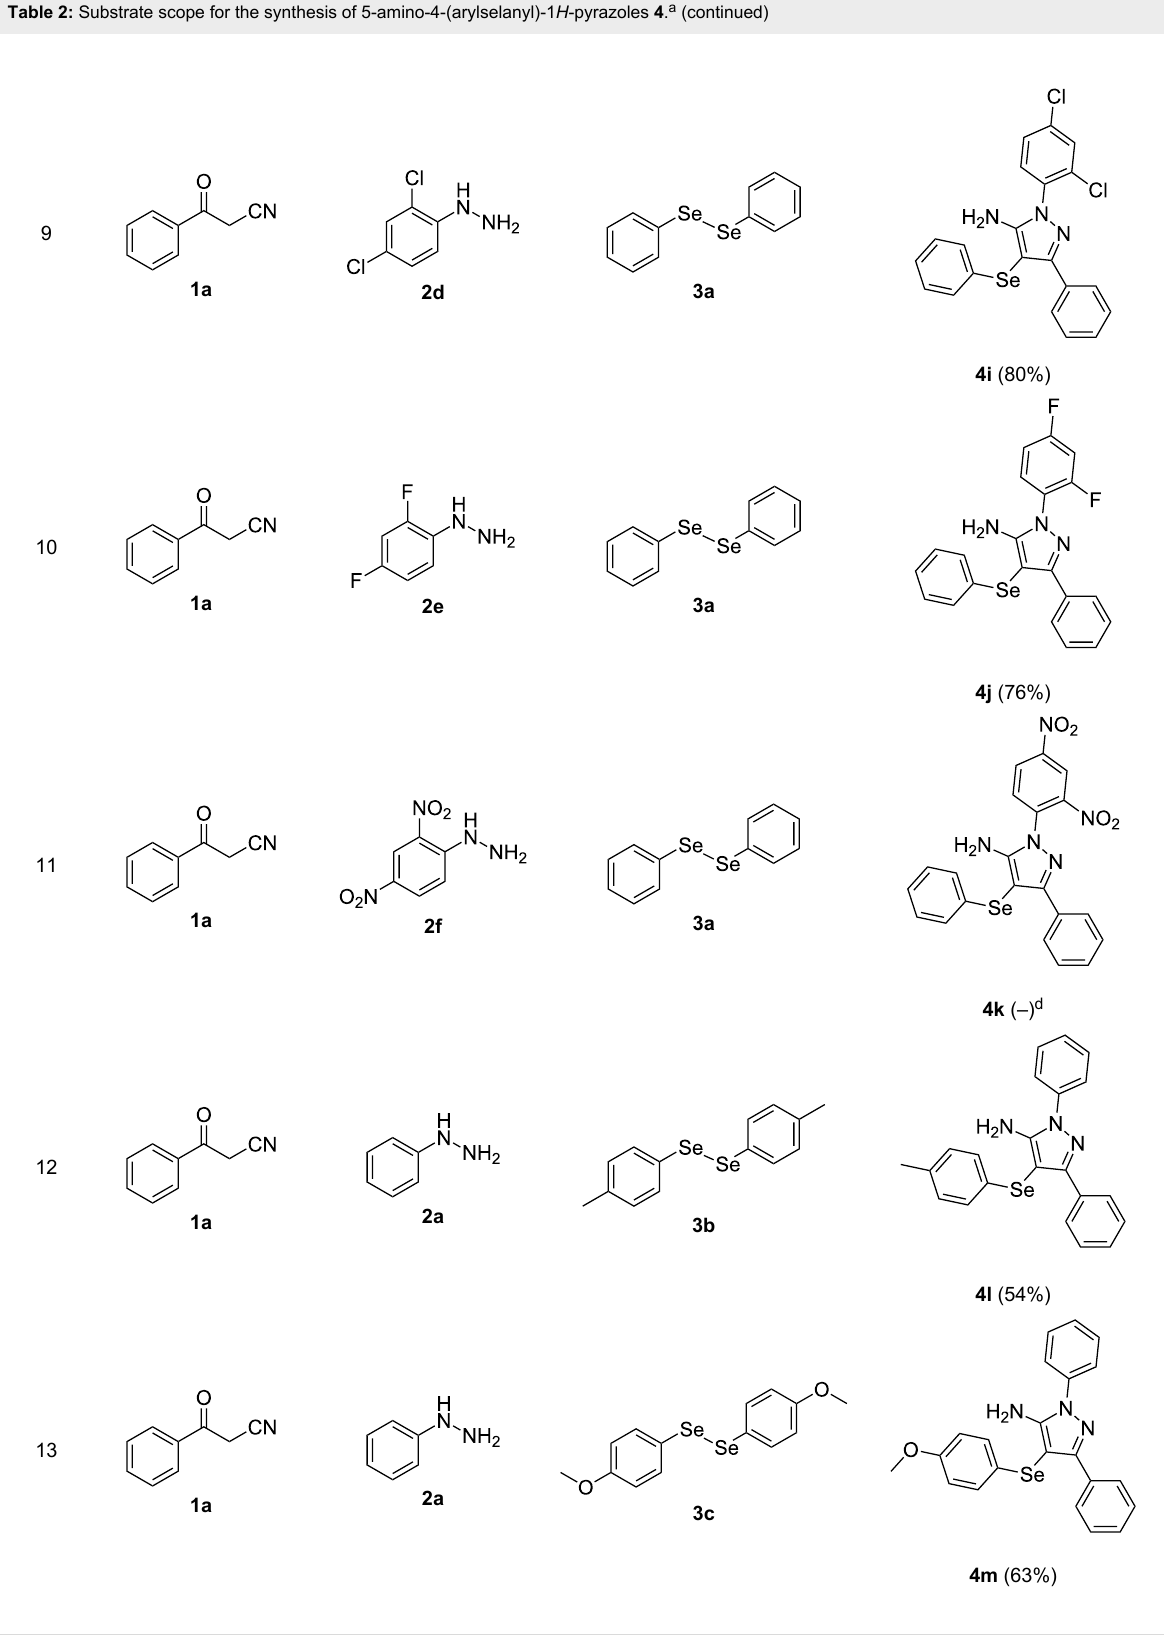
Table 2: Substrate scope for the synthesis of 5-amino-4-(arylselanyl)-1 H -pyrazoles 4 . a